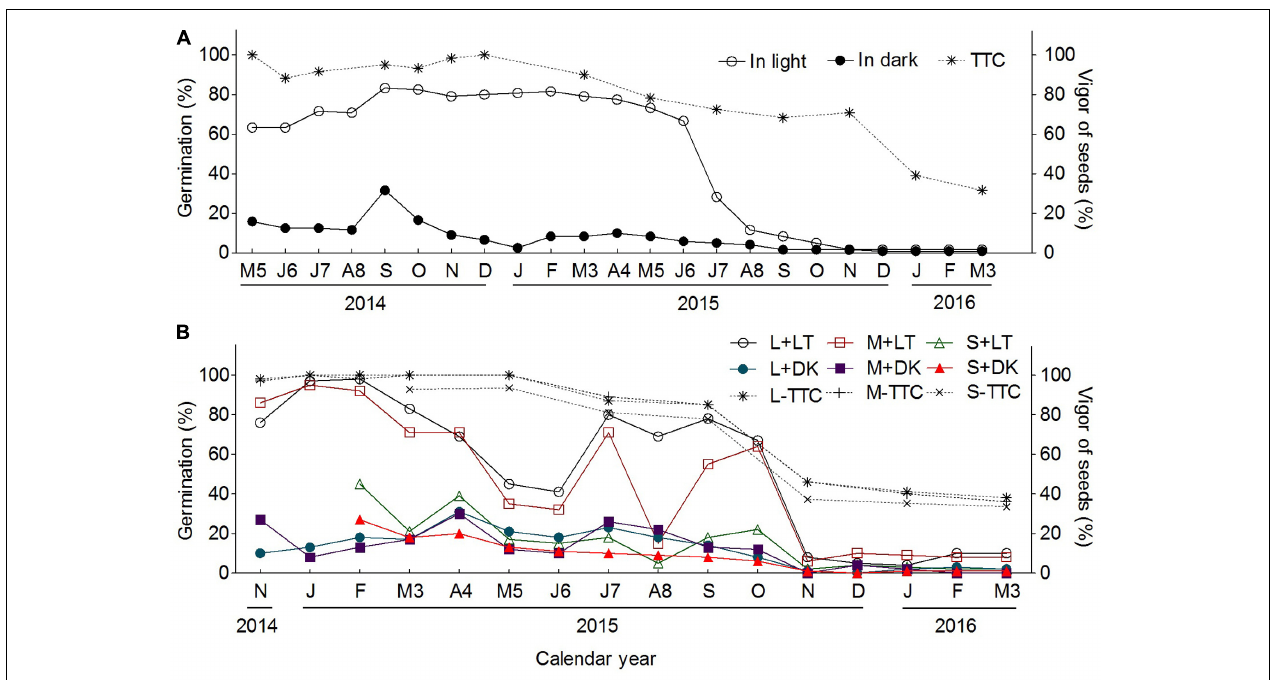
FIGURE 11 | Effect of room storage on seed germination and analysis of seed vigor of S. ferganica. (A) Seeds collected from 2013; (B) seeds collected from 2014. 2014, 2015, 2016: represent seed germination performed in 2014, 2015, 2016 calendar year, respectively. J, January; F, February; M3, March; A4, April; M5, May; J6, June; J7, July; A8, August; S, September; O, October; N, November; D, December. L, M, S, large, middle, small seed. LT, light; DK, dark. TTC: 2,3,5-triphenyltetrazolium